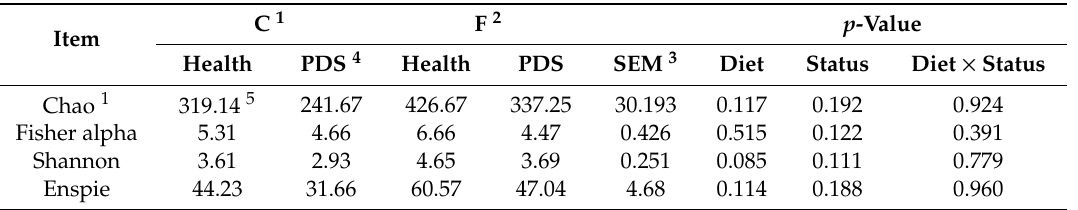
Table 5. Effect of Bacillus licheniformis -fermented products and postpartum dysgalactia syndrome on the microbial diversity in the fecal content of sows.